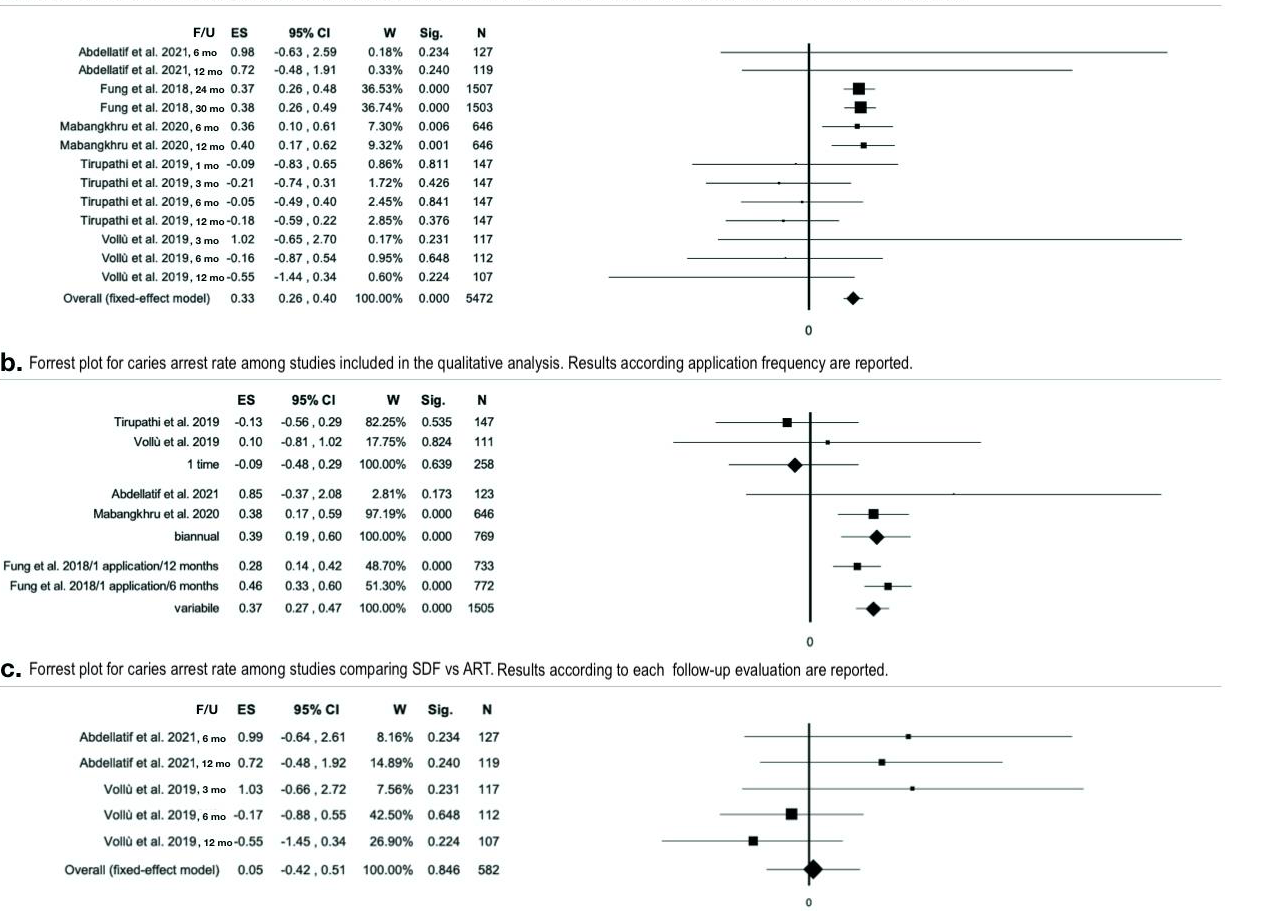
Figure 3. Metanalyses [35,37,39–41]. ( a ) Forest plot for caries arrest rate. Results for each study (fixed-effect model) are combined for subgroups but not for follow-ups; ( b ) forest plot for caries arrest rate comparing different application frequency. Moderator analysis (application as categorical moderator), overall forest plot (fixed-effect model) combined for follow-up; ( c ) forest plot for caries arrest rate among studies comparing SDF and ART (fixed-effect model) combined for subgroups but not for follow-ups.